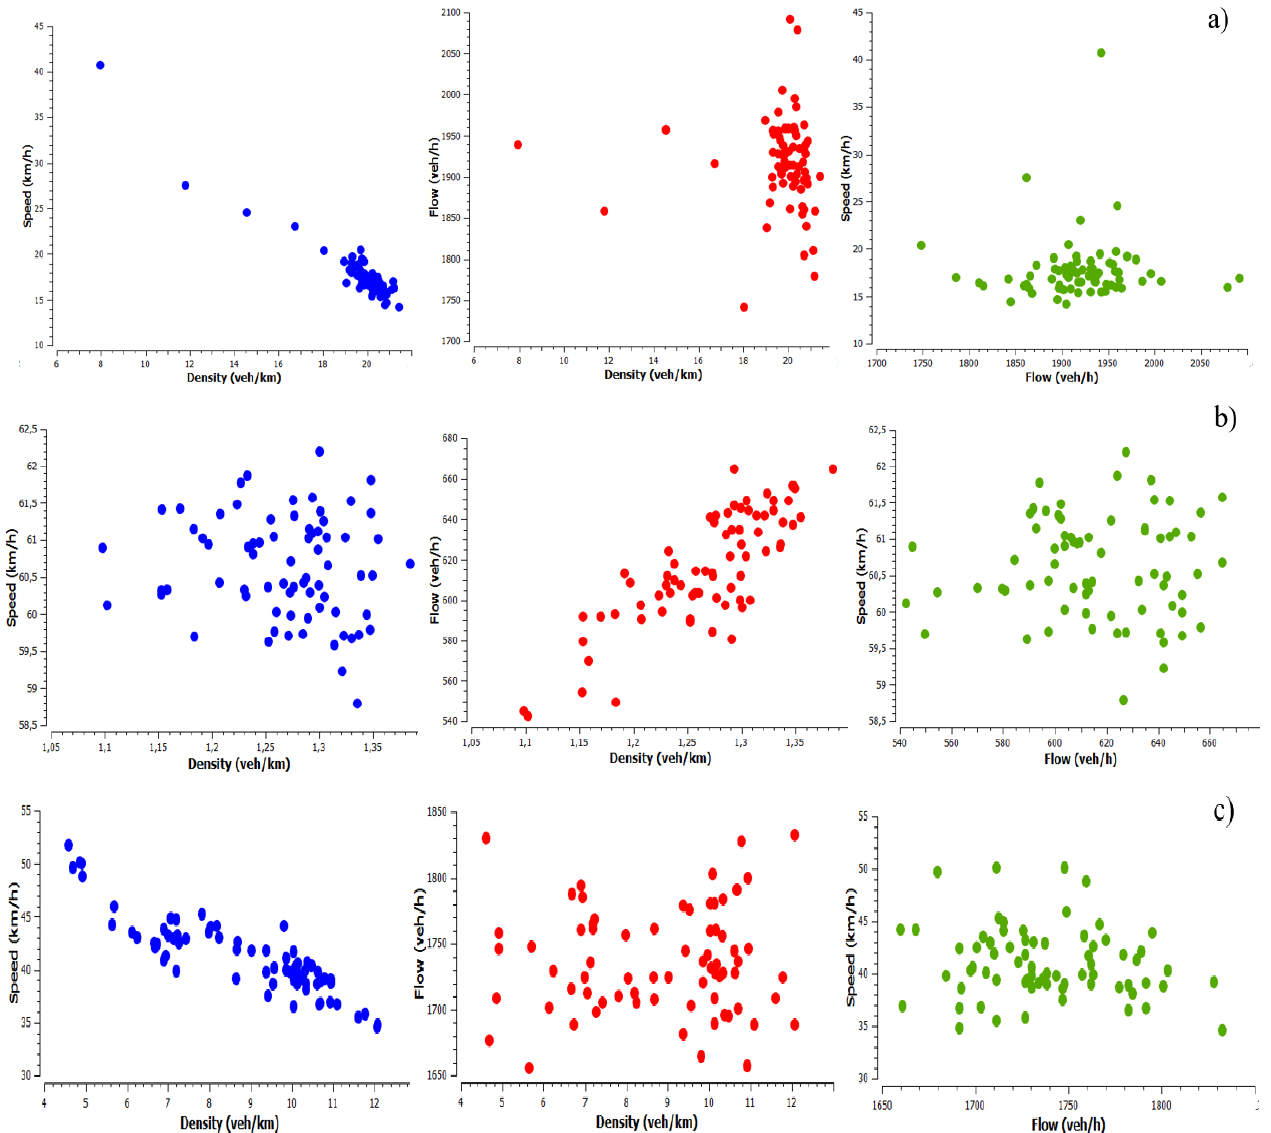
Figure 5. Basic characteristics of the traffic flow in 2019 ( a ), 2020 ( b ), and 2021 ( c ). A decrease in traffic intensity is a predictor of a higher traffic speed and a lower